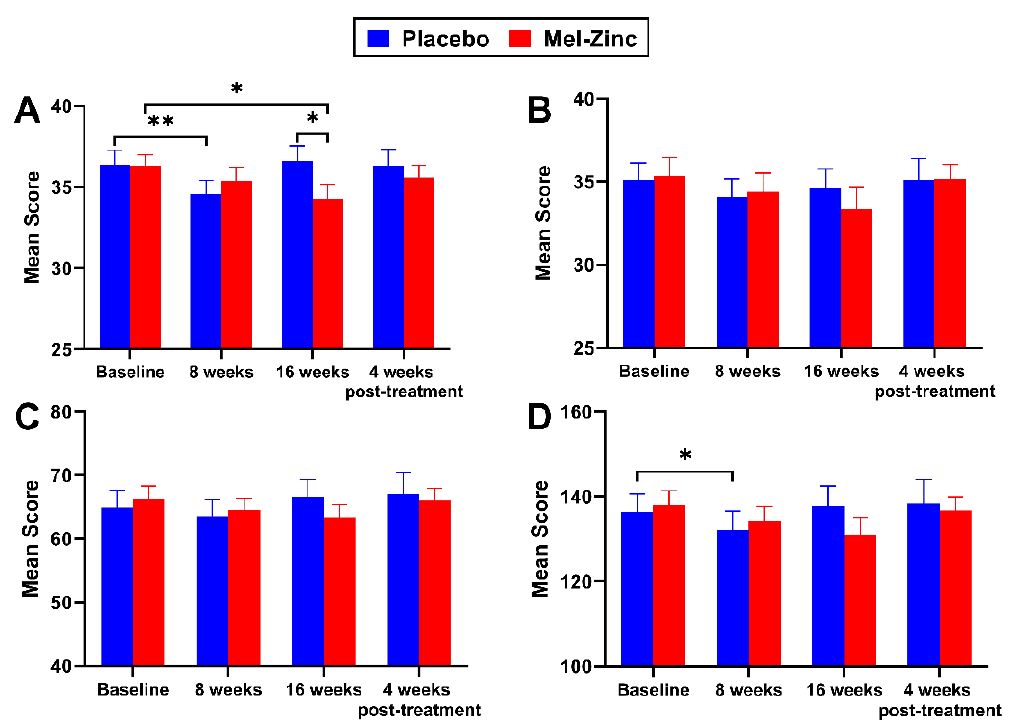
Figure 3. Changes in the FIS-40 domain scores during the intervention study. Each bar indicates the mean FIS-40 item scores ± SEM compared by a paired Student’s t-test, where appropriate, for intragroup analysis and by a Wilcoxon’s signed rank test for intergroup analysis. ( A ) Physical functioning domain; ( B ) Cognitive domain; ( C ) Psychological domain; ( D ) Total FIS-40 score. The significance threshold was set at * p < 0.05 and ** p < 0.01. No significant differences in any FIS-40 domain scores were observed between the intervention groups in the rest of study visits. Lower scores indicate an improvement in the fatigue perception among participants. Abbreviations: Mel-Zinc, Melatonin plus Zinc group; FIS-40, 40-item fatigue index